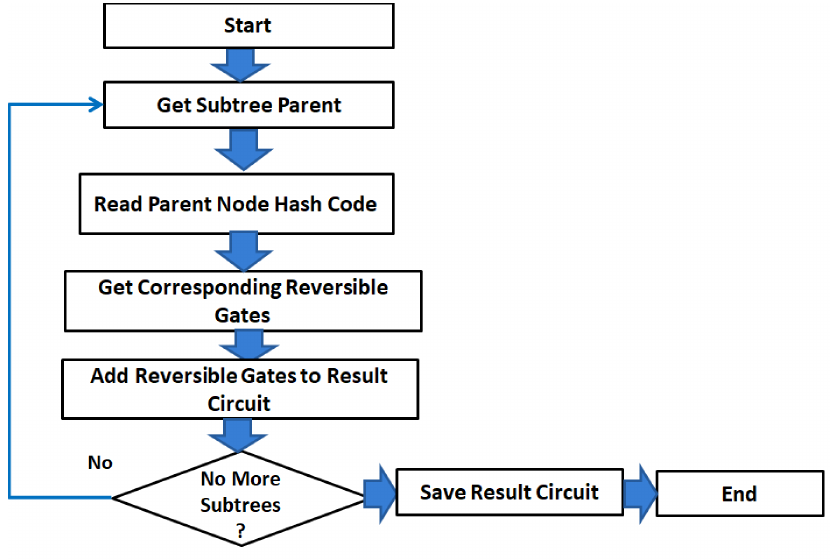
Figure 7. Subtree-based realization of reversible